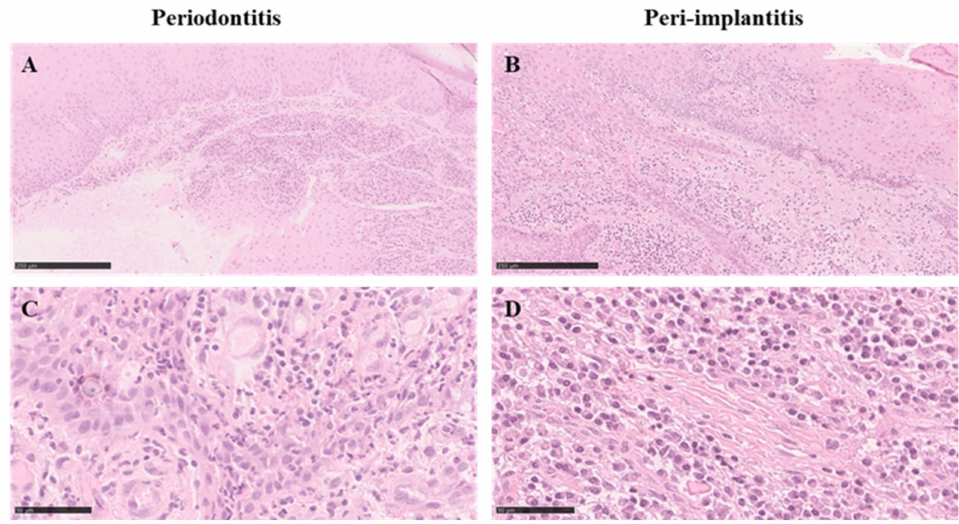
Figure 3. Sections of periodontitis and peri-implantitis tissues stained with HE: ( A , B ) low magnifica- tion; ( C , D ) high magnification.